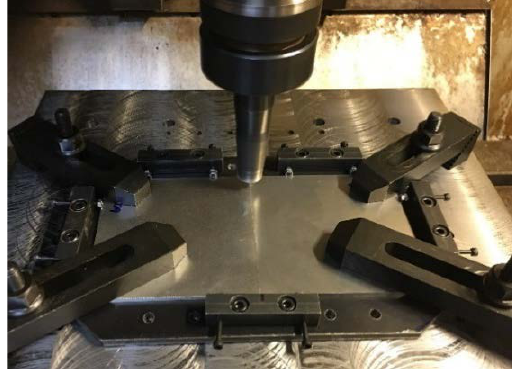
Figure 3. Friction stir welding process.